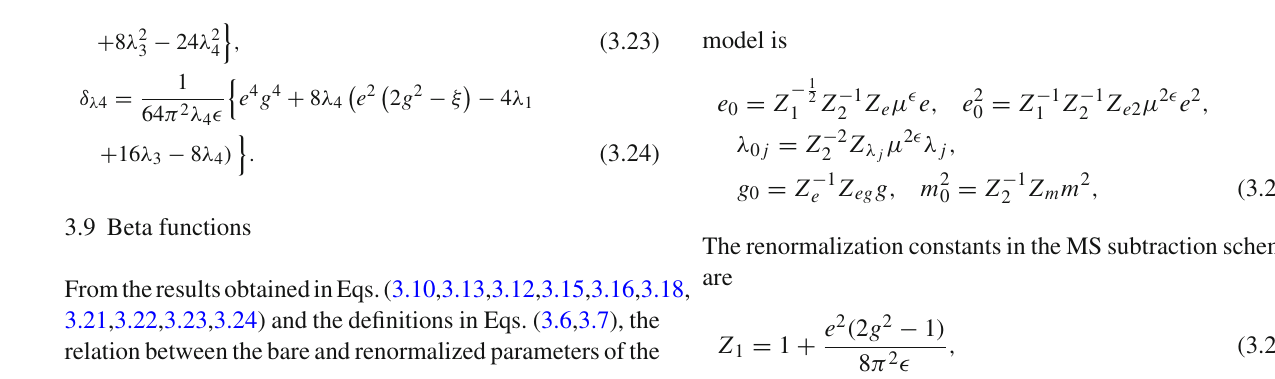
Fig. 8 Feynman diagrams for the γγγγ vertex at one-loop. There are 9 additional diagrams obtained from diagrams 1 − 9 reversing the arrow direction in the